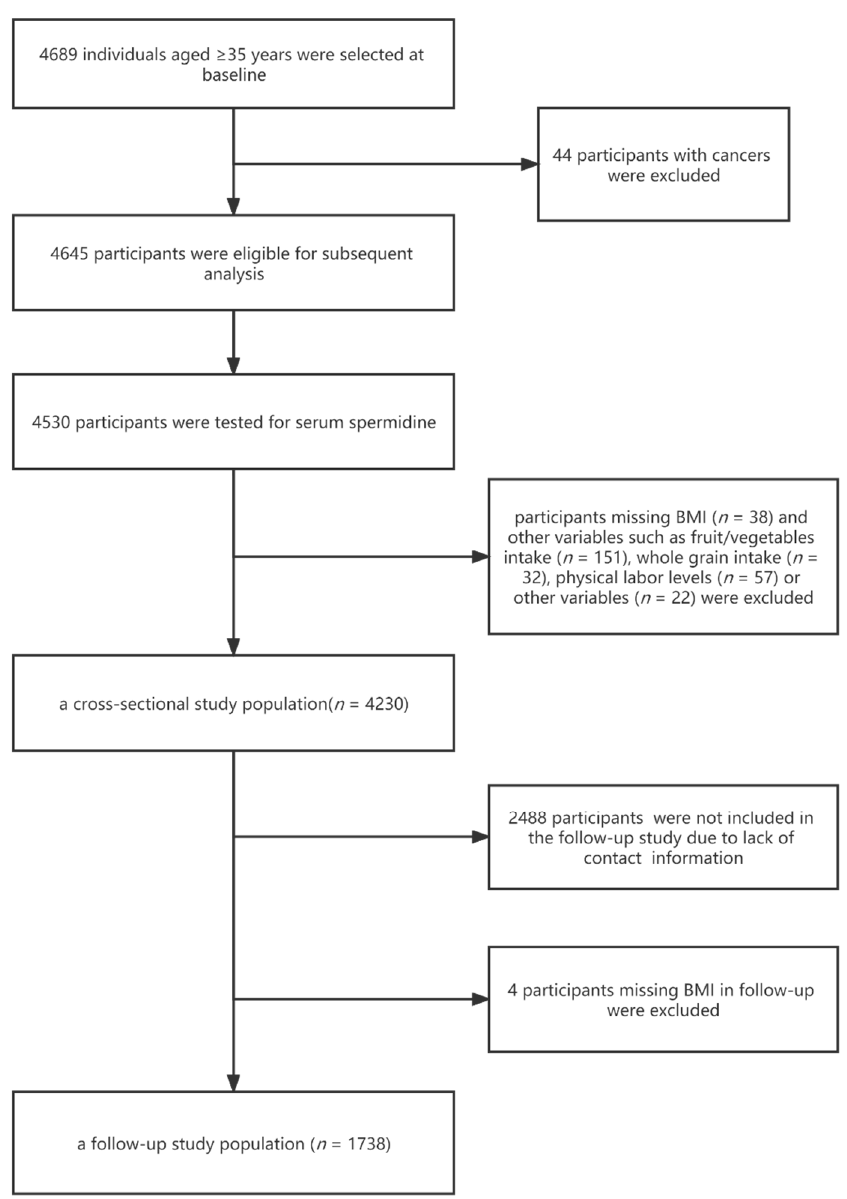
Figure 1. The study population inclusion and exclusion